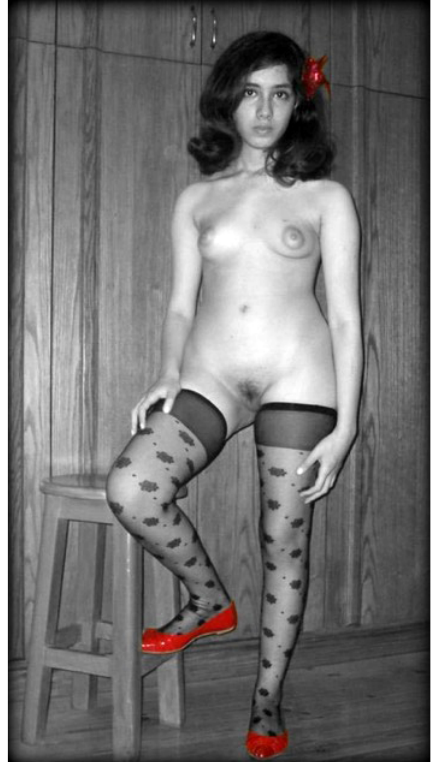
Figure 1. Aliaa Magda Elmahdy nude self-portrait (selfie) published on her blog “A Rebel’s Diary”, in